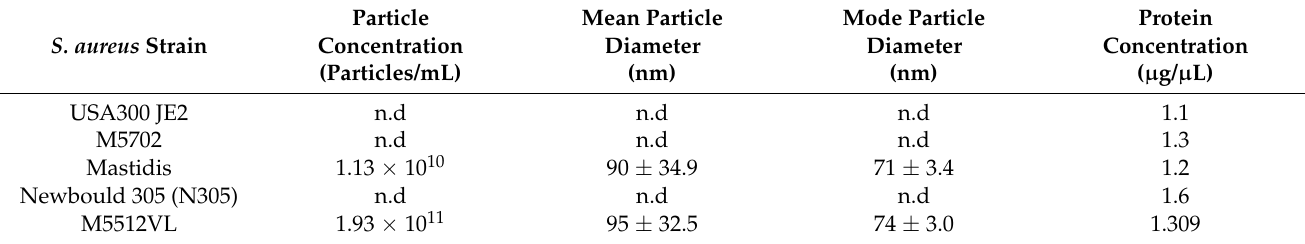
Table 2. Particle concentration, mean and mode particle diameter and protein concentration were measured in each pellet of S. aureus